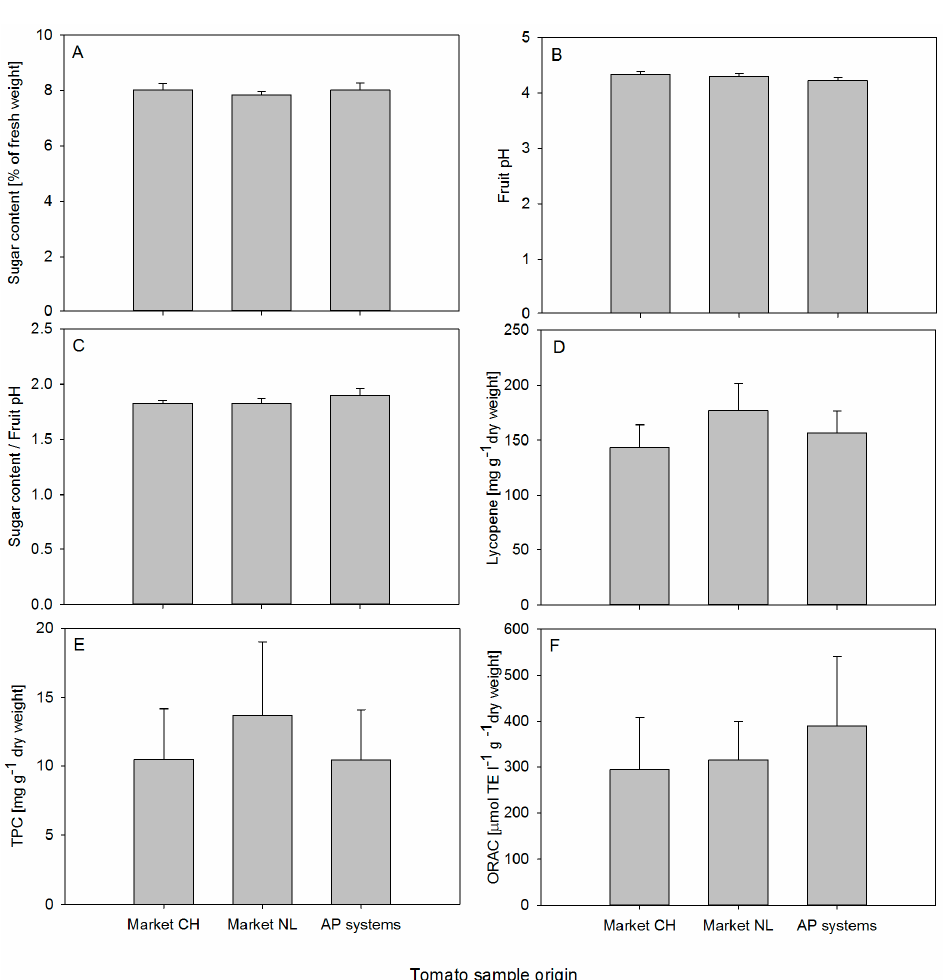
Figure 5. Fruit internal quality parameters sugar content ( A ); fruit pH ( B ); sugar–acid ratio ( C );